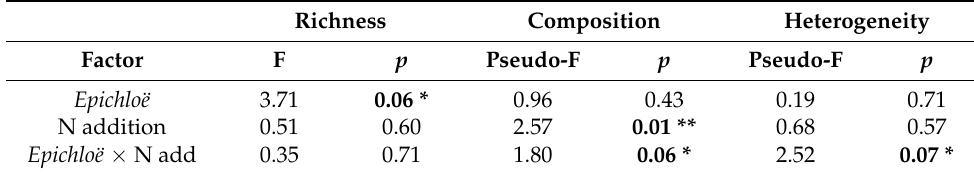
Table 1. Statistical results from analyses of root fungal endophyte species richness (GLM), community composition (PERMANOVA), and community heterogeneity (PERMDISP). Statistically significant results are indicated in bold and by an asterisk (* p < 0.10, ** p < 0.05). Richness Composition Heterogeneity Factor F p Pseudo-F p Pseudo-F p Epichloë 3.71 0.06 * 0.96 0.43 0.71 N addition 0.51 0.60 Epichloë × N